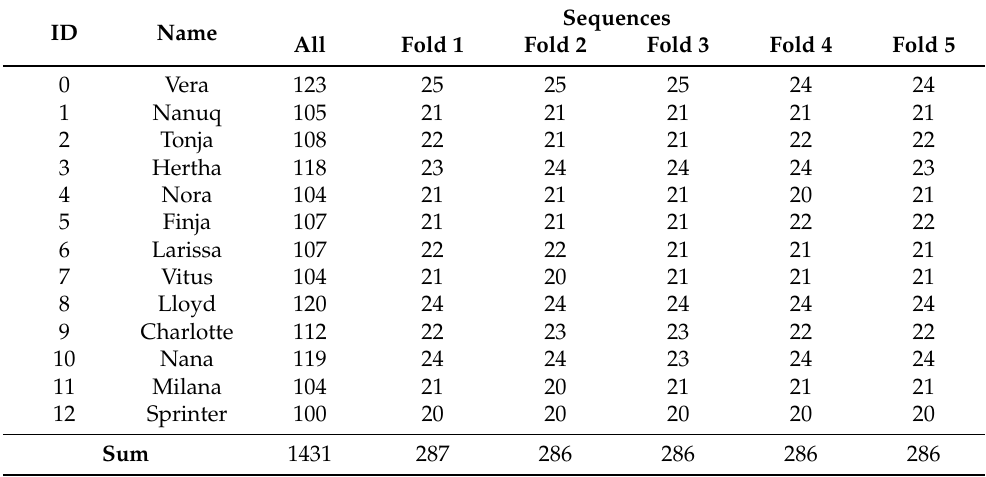
Table A1. Number of sequences for each polar bear and the distribution of data over the folds.